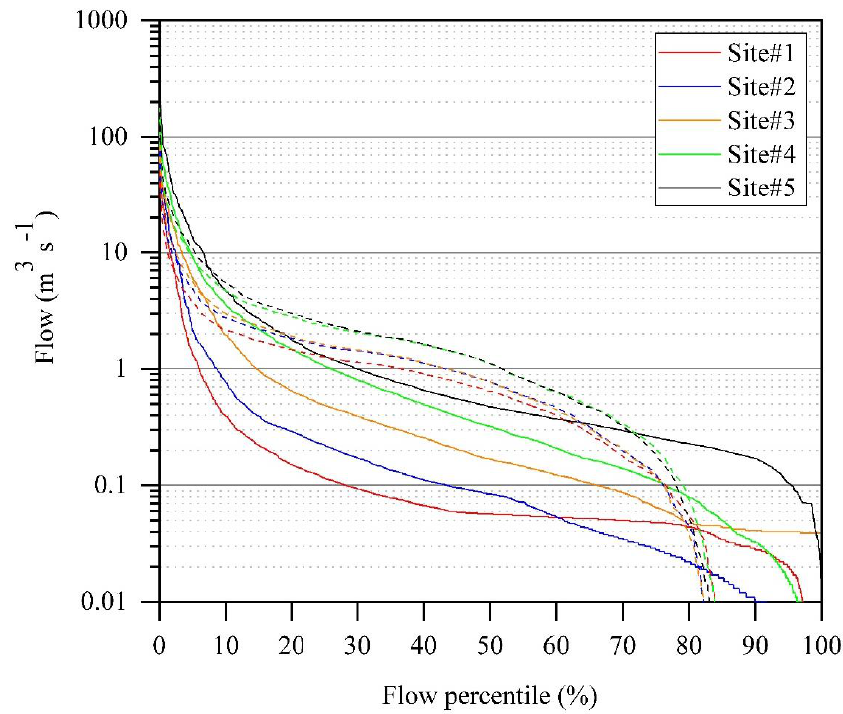
Figure 3. Simulated (dashed line) and observed (solid line) daily average flow duration at five gauging sites in Hinkson Creek, MO, USA.